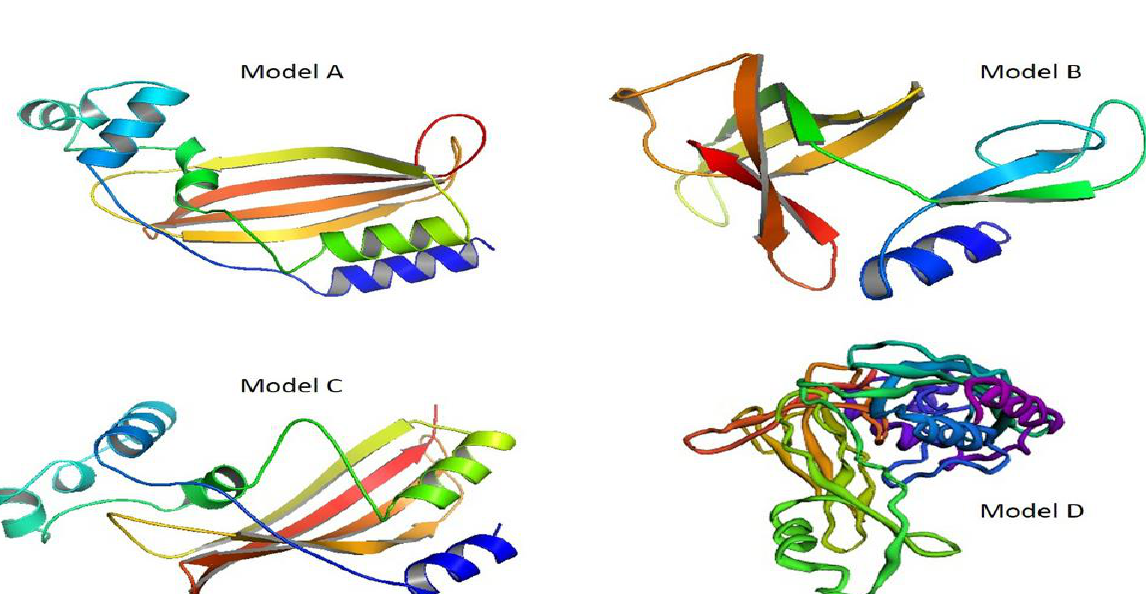
Fig. 2. The 3D structures Model A, Model B, Model C, and Model D of uncharacterized protein MBO_502153 predicted by Swiss Model, HHpred, Phyre2, and Robetta server.